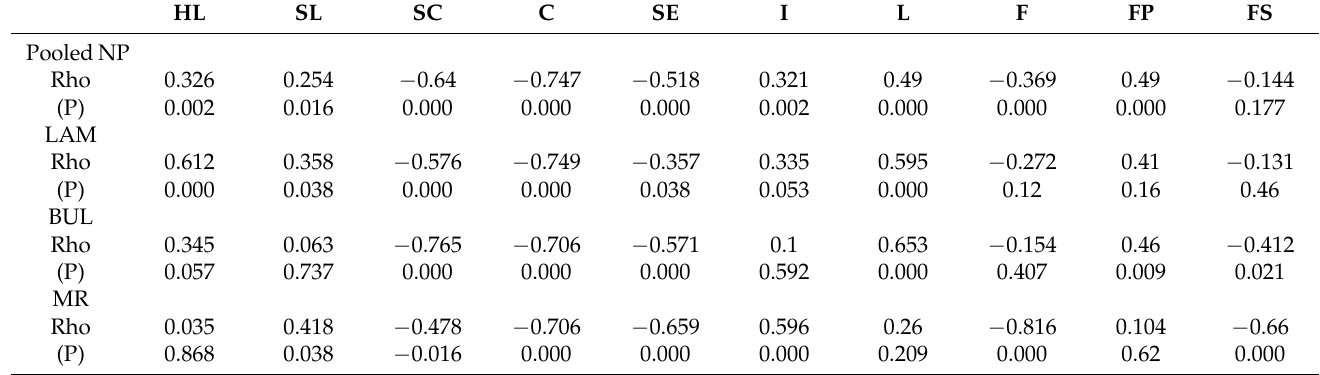
Table 2. Spearman’s Rho correlation of structure; HL = Herb Layer % cover, SL = Shrub Layer % cover, SC = Sub-canopy % cover, C = Canopy % cover and regrowth parameters S = Seedlings, I = Phytolacca octandra (inkweed) % cover, L = Lantana camara, F = Ferns, FP = Sum of fire-promoting variables (L = Lantana, WV = Woody Vines, WVC = WoodyVine Clumps, D = Disturbance), FS = sum of fire-supressing variables (SE = Seedlings R = Resprouting F = Ferns, NWV = Non-Woody Vines) against dnBR fire-severity values. Results (Rho and p) for combined NP as well as at each individual National Park (LAM = Lamington, BUL = Bulburin, MR = Main Range) are shown. The following Bonferroni variables were considered, where significance is identified by the p